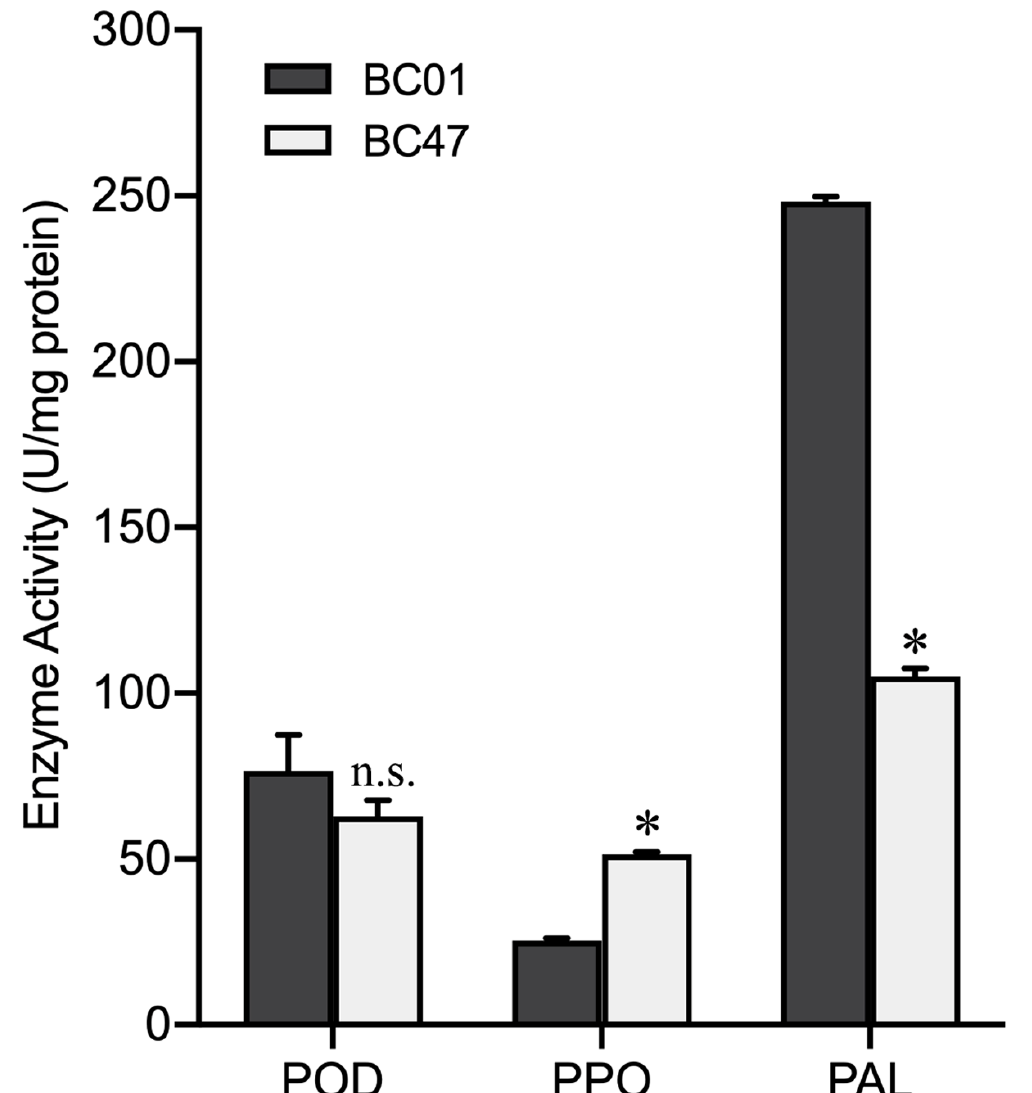
Figure 5. Activities of three defense-related enzymes in the susceptible and resistant Ethiopian mustard leaves. Notes: Bars are the means ± SE with three biological replicates. Asterisks indicate statis- t ically significant values from those of BC01 (Fisher’s LSD test; p < 0.05); n.s.: no statistical signifi- cance between BC01 and BC47.